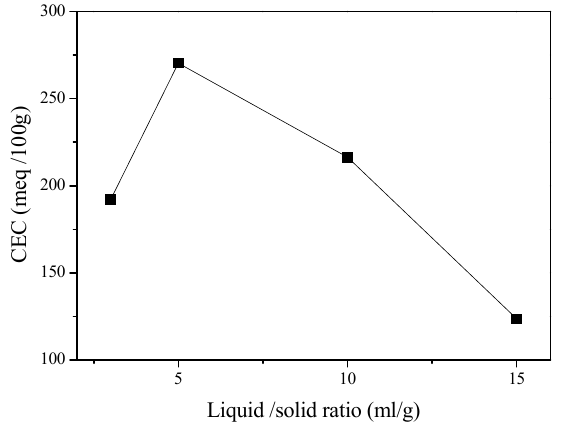
Figure 2. Effect of liquid/solid ratio on the CEC of synthesized zeolite (NaOH/coal fly ash ratio 1.2 g/g, 1.5 h alkali fusion under 550 °C, 15 h hydrothermal treatments under 90 °C).